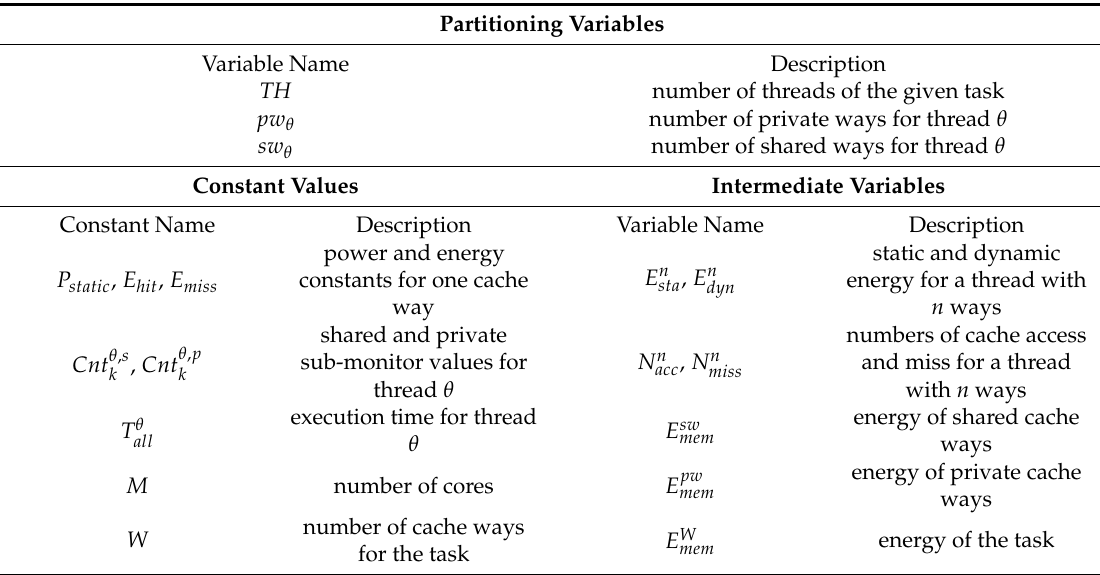
Table 1. Variables and Constants of the MILP Problem for Stage-1.